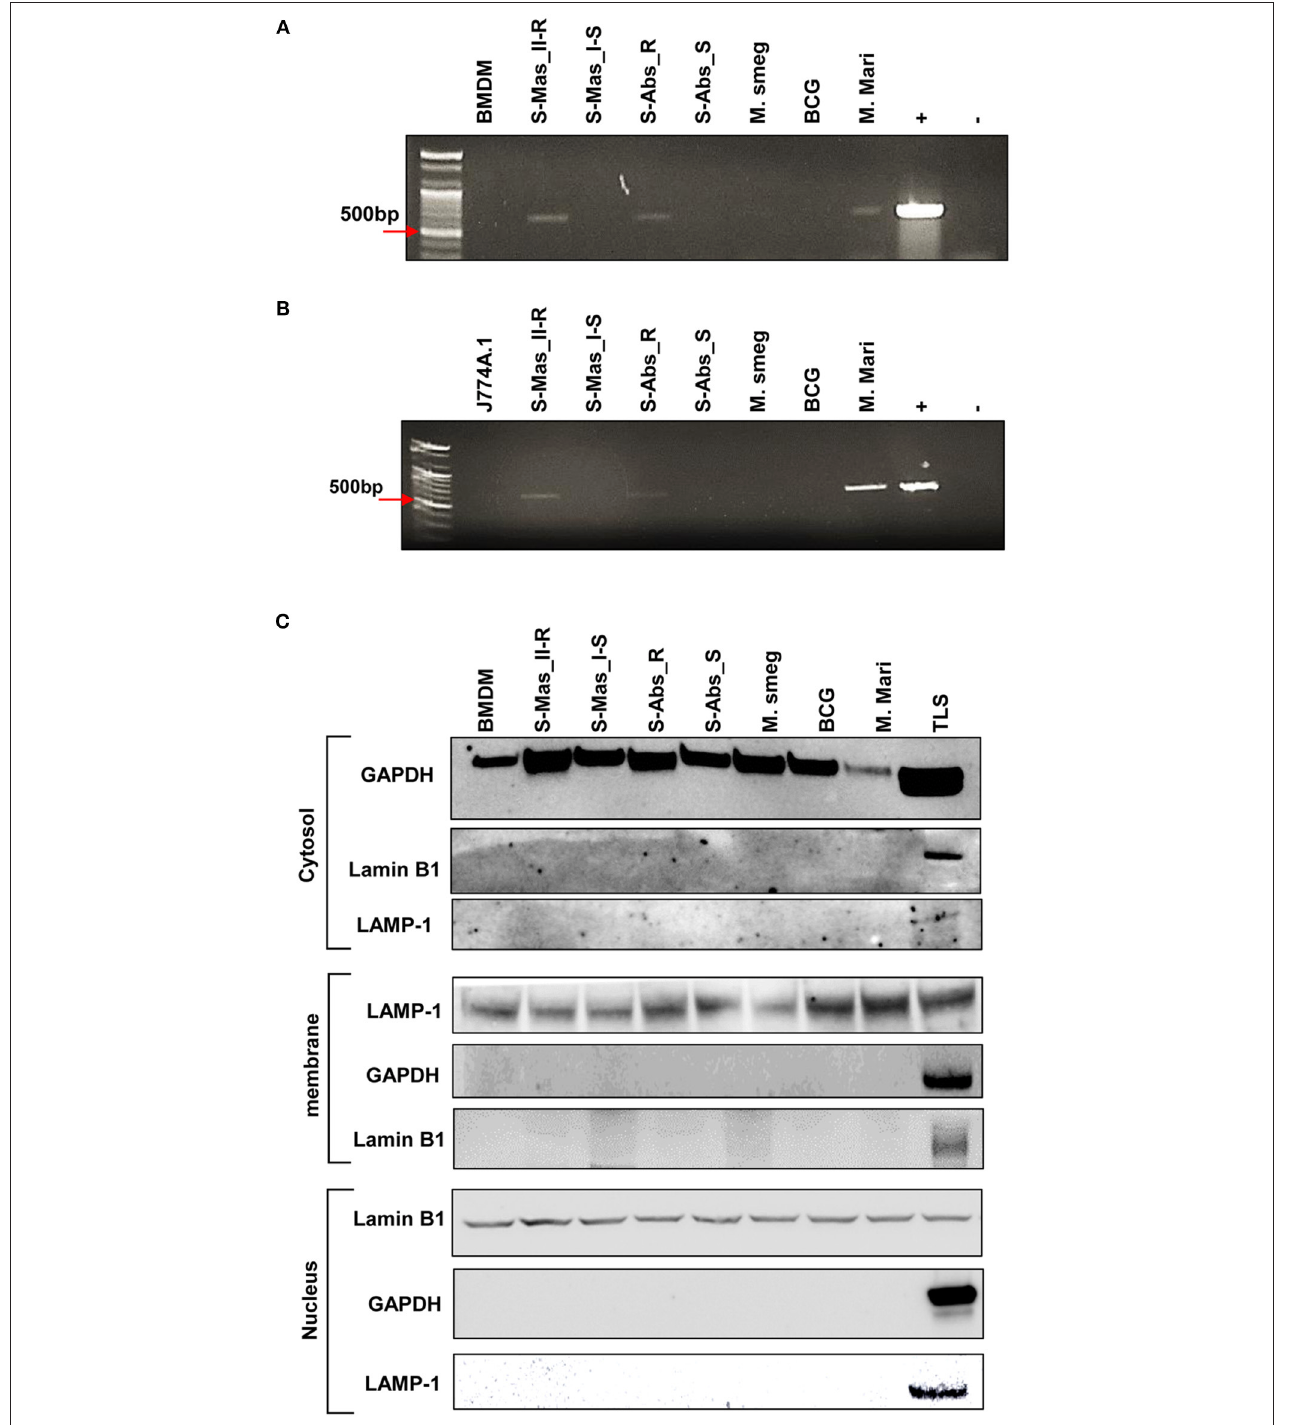
FIGURE 3 | Detection of mycobacterial DNA from the cytosolic region of MAB-R-infected murine macrophages by PCR. (A,B) BMDMs (A) and J774A.1 cells (B) infected with MAB-R and -S strains [S-Mas_II-R (Asan 50594), S-Mas_I-S (Asan-51843) S-Abs_R (M. abscessus type strain ATCC 19977 rough strain), S-Abs_S ( M. abscessus type strain ATCC 19977 smooth strain)], M. smeg ( M. smegmatis ), BCG ( M. bovis BCG), and M. mari ( M. marinum ) at 37 ◦ C for 24 h. Cytosolic DNA (from cytosol fractionation) was extracted by the phenol-chloroform-isoamyl alcohol (PCI) method. Cytosolic DNA was detected by PCR amplification of the hsp65 (603 bp) gene ( + , mycobacterial DNA; − , containing only primers). (C) Cytosolic cell fractions were isolated using the manufacturer’s protocol for the Qproteome Cell